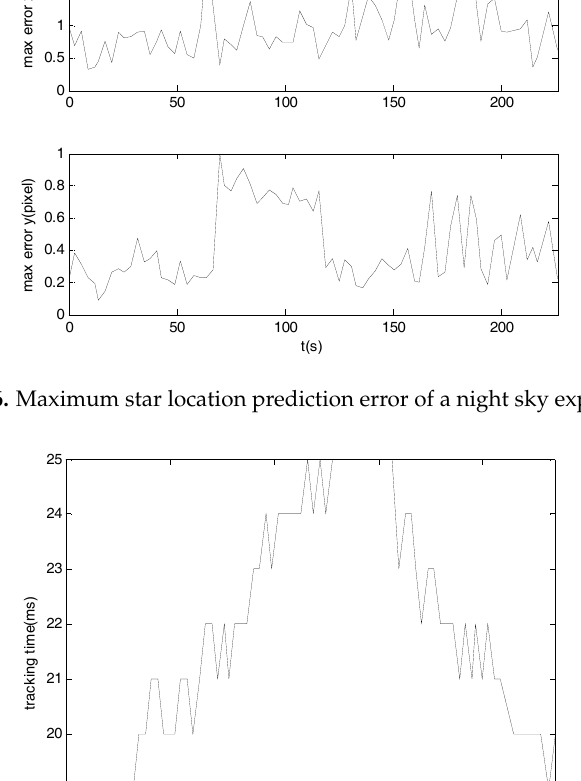
Figure 18. Time to simulate the reference star image versus N.